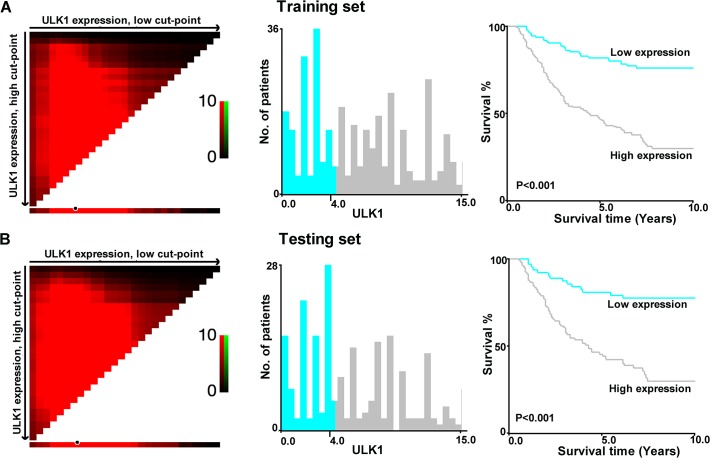
X-title plots of ULK1 expression for optimal cut-point selection in the training cohort.Patients in the training cohort were randomly divided into equal training (A) and pretesting subsets (B). The cut-point for the training set (IHC score > 4, P<0.001) is demarcated by the circle (black with white border), which was then used as the point separating low ULK1 expression (blue) from high ULK1 expression (gray) in the expression frequency of the whole set (middle panel). The right panel presents the Kaplan-Meier curve for examining the survival of cohort subsets defined by ULK1 expression ⩽4(blue line) and >4 (gray line).